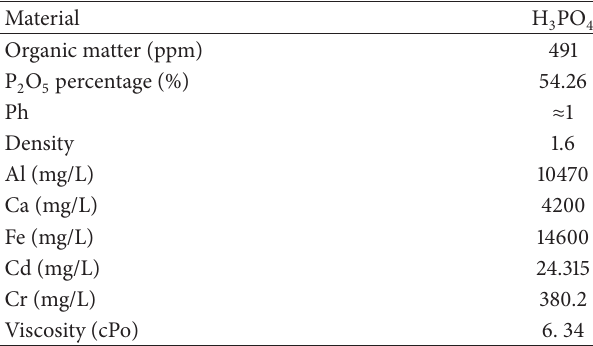
Table 1: Physical and chemical characteristics of 54% industrial phosphoric acid